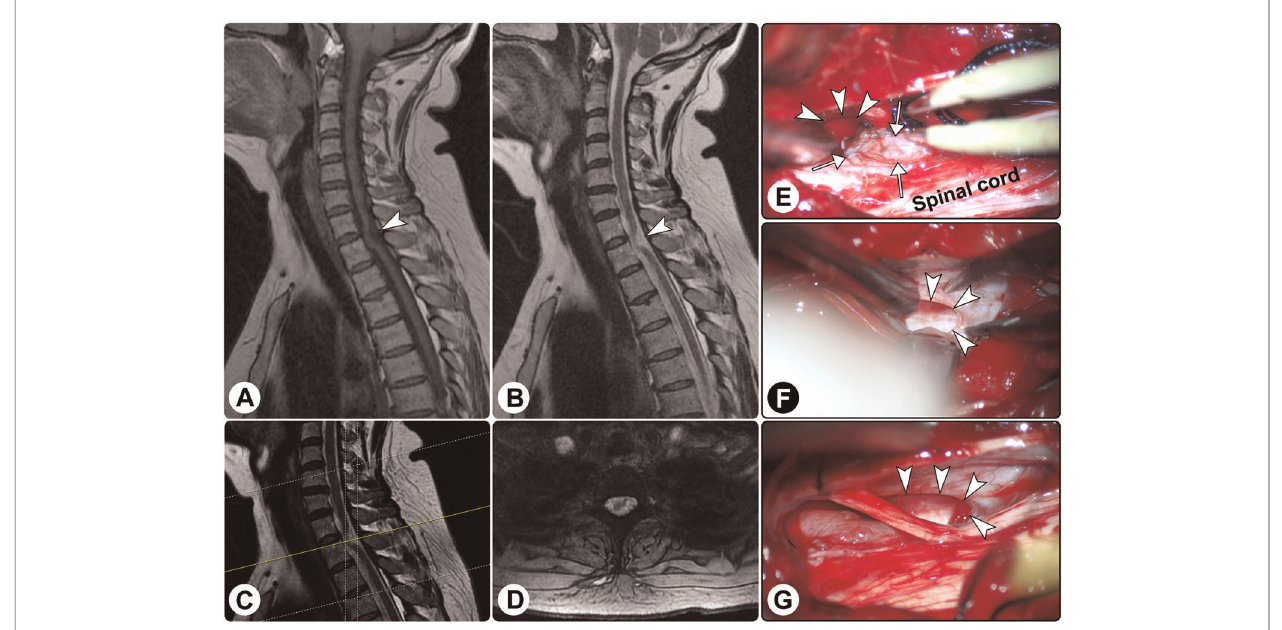
FIGURE 1 | Spinal magnetic resonance imaging and intraoperative fi ndings. Spinal magnetic resonance imaging showed the spinal cord was distorted (( A ) sagittal T1-weighted imaging; ( B ) sagittal T2-weighted imaging; ( C ) the yellow line indicating the locating plane; ( D ) axial T2-weighted imaging). ( E – G ) Intraoperatively, a dural defect was found (white arrowheads), and surgical reduction of the herniated spinal cord (white arrows) was